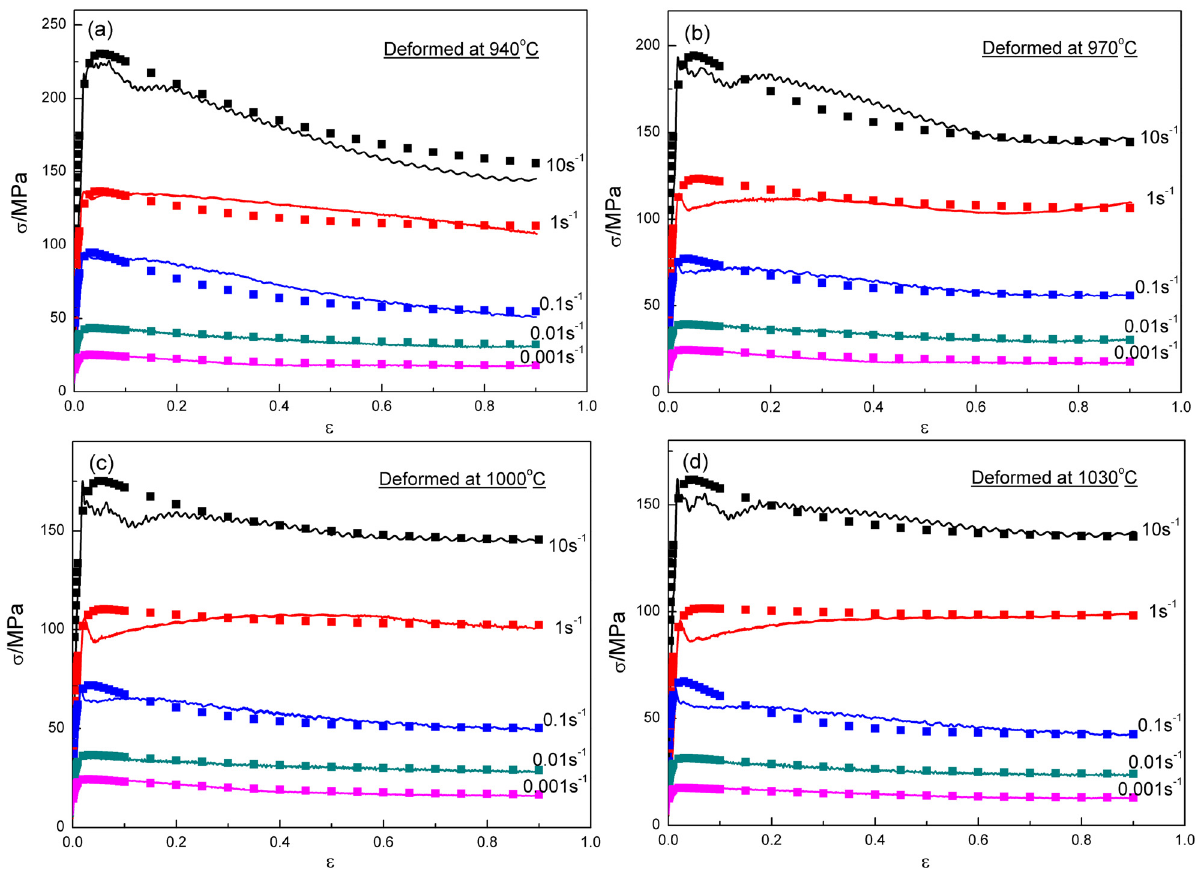
Figure 13: Comparison between predicted and experimental fl ow curves at temperatures of: ( a ) 940°C; ( b ) 970°C; ( c ) 1,000°C; and ( d ) 1,030°C ( the curves represent experimental results and symbols represent predicted ones )